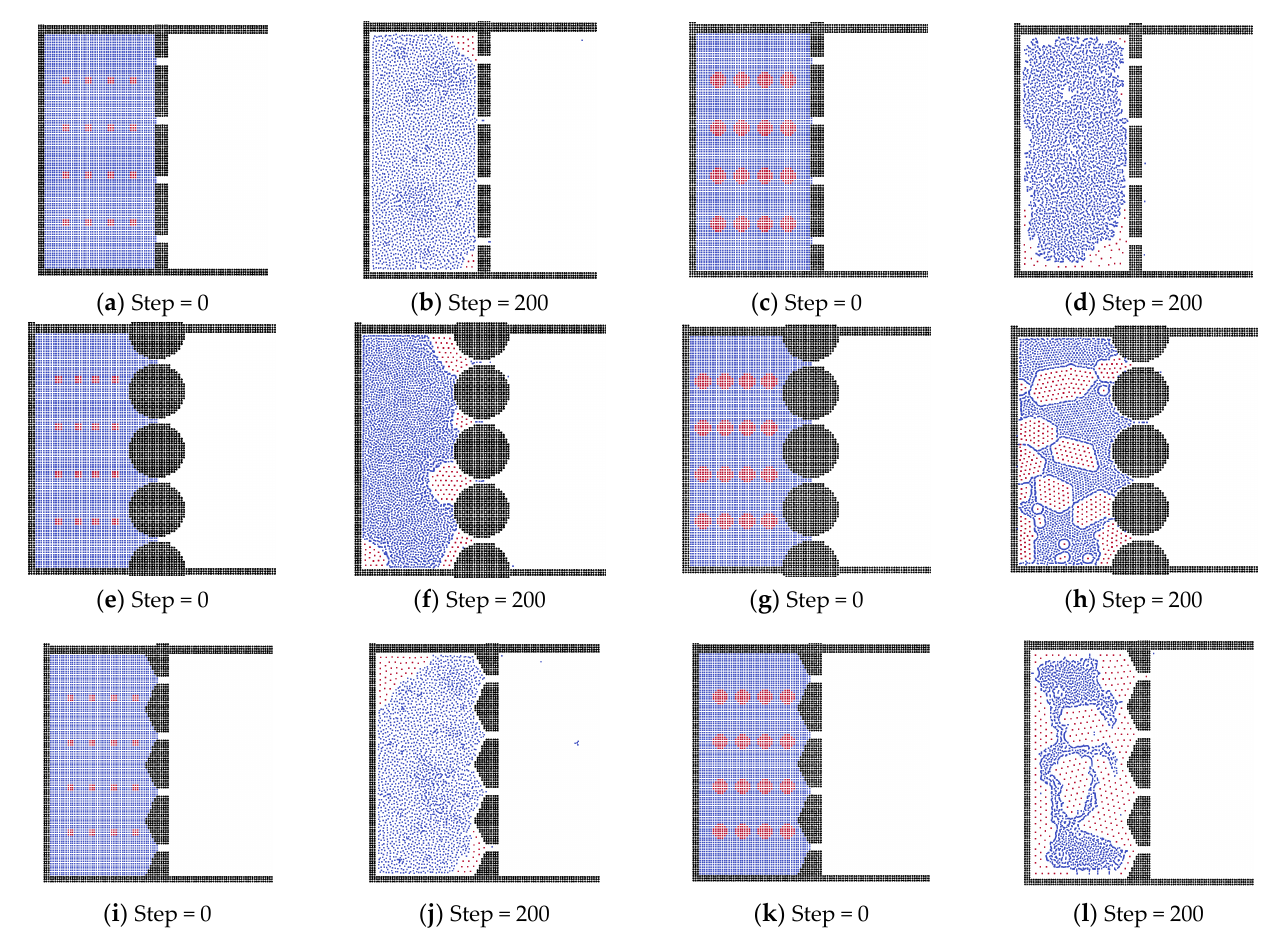
Figure 7. The different oil droplet size systems in membrane for the oil–water separation, ( a , b , e , f , i , j ) forming oil droplets with radii of 4 μ m; ( c , d , g , h , k , l ) forming oil droplets with radii of 8 μ m.